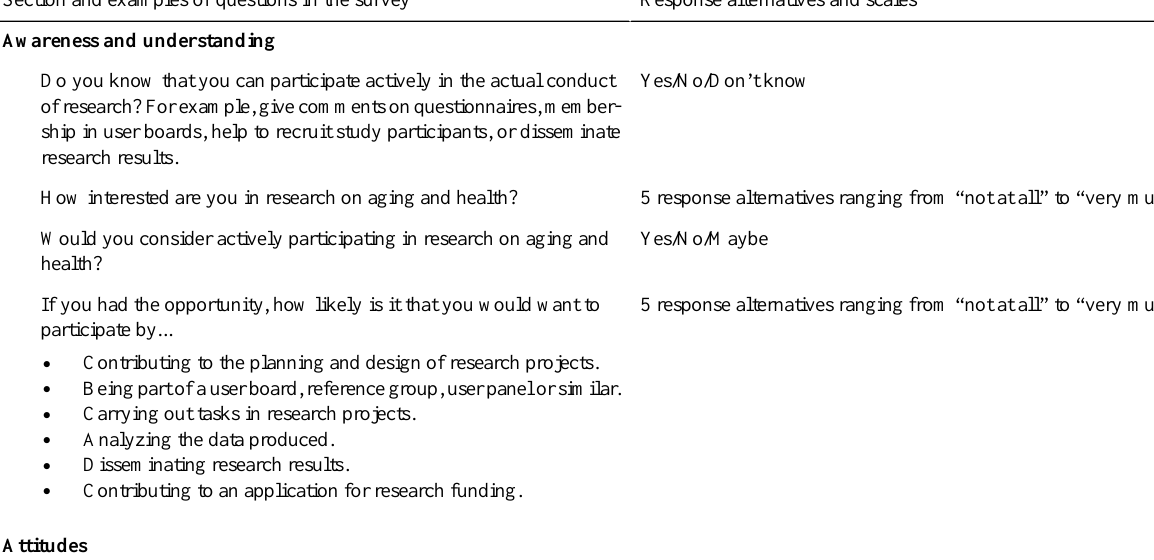
Response alternatives and scalesSection and examples of questions in the survey